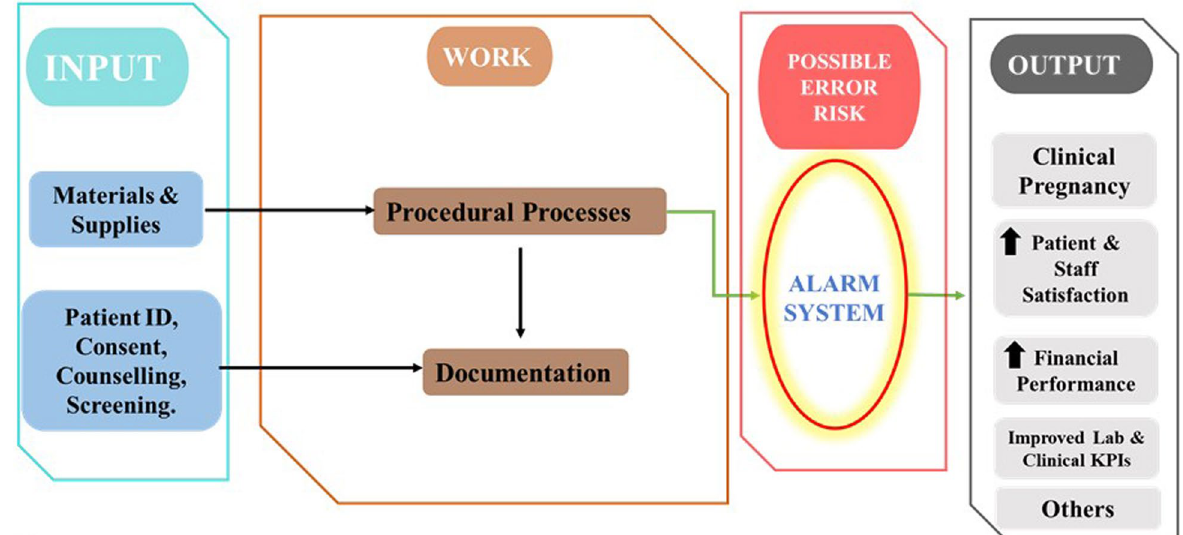
desired outputs or